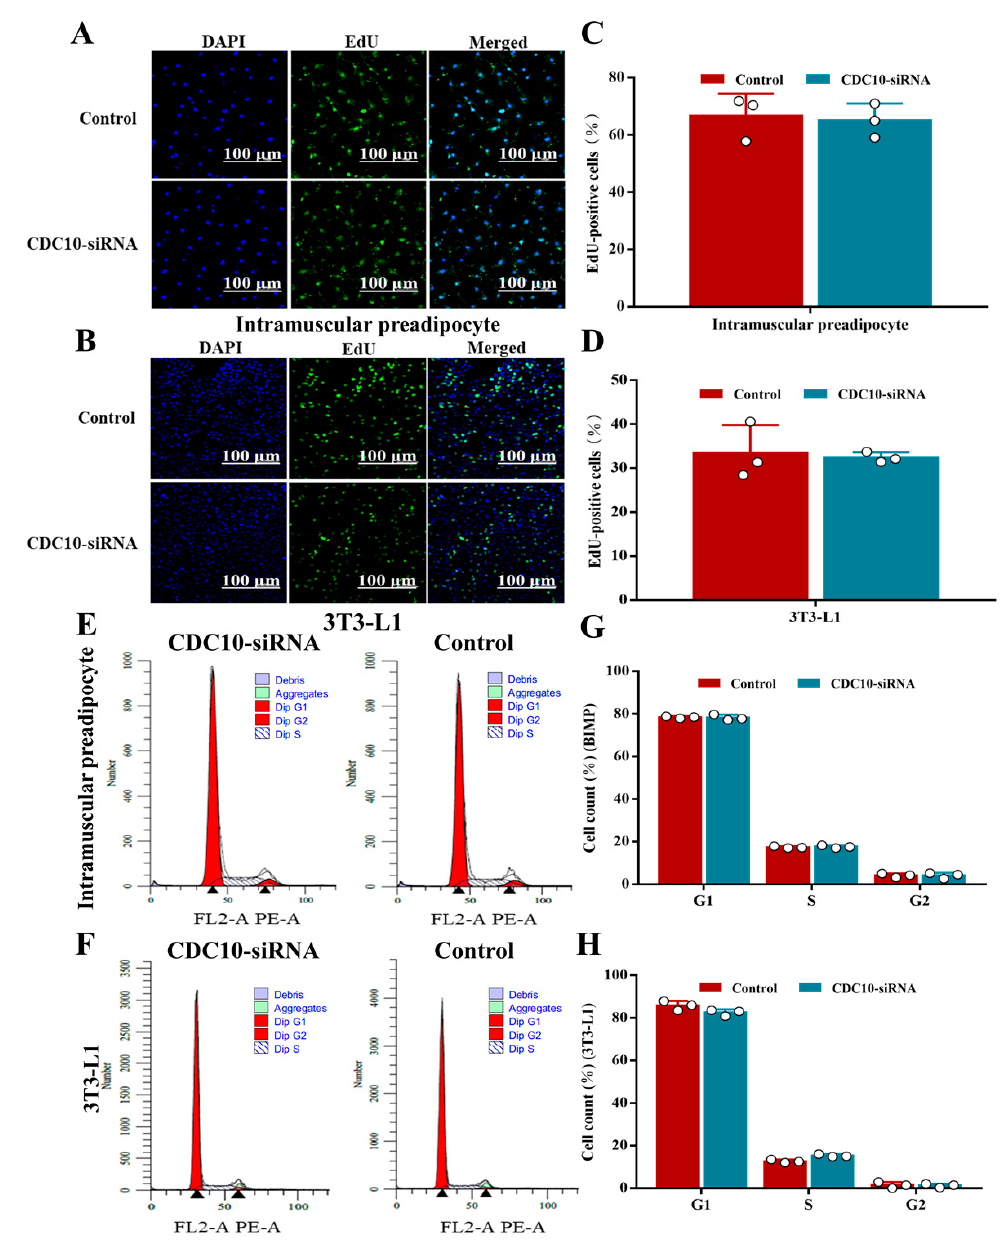
Figure 4. The effect of CDC10 knockdown on the proliferation of bovine intramuscular preadipocyte (BIMP) and 3T3-L1 cells was detected by EdU and flow cytometry assay. BIMP and 3T3-L1 cells were transfected with CDC10 -siRNA for 48 h during proliferation. ( A , B ) The proliferations of BIMP and 3T3-L1 cells were examined by EdU immunofluorescent staining. Green color represents EdU staining and blue color represents cell nuclei stained with Hoechst 33342. ( C , D ) The percentage of EdU-positive cells were quantified. ( E – H ) Cell cycle phase analysis of BIMP and 3T3-L1 cells by flow cytometry and their statistical results. Values are expressed as mean ± SEM ( n = 3).